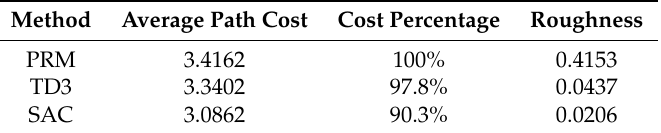
Figure 13. Path difference between PRM-TD3 with HER and PRM-SAC with HER by PRM. Table 3. Comparison of the proposed result with existing